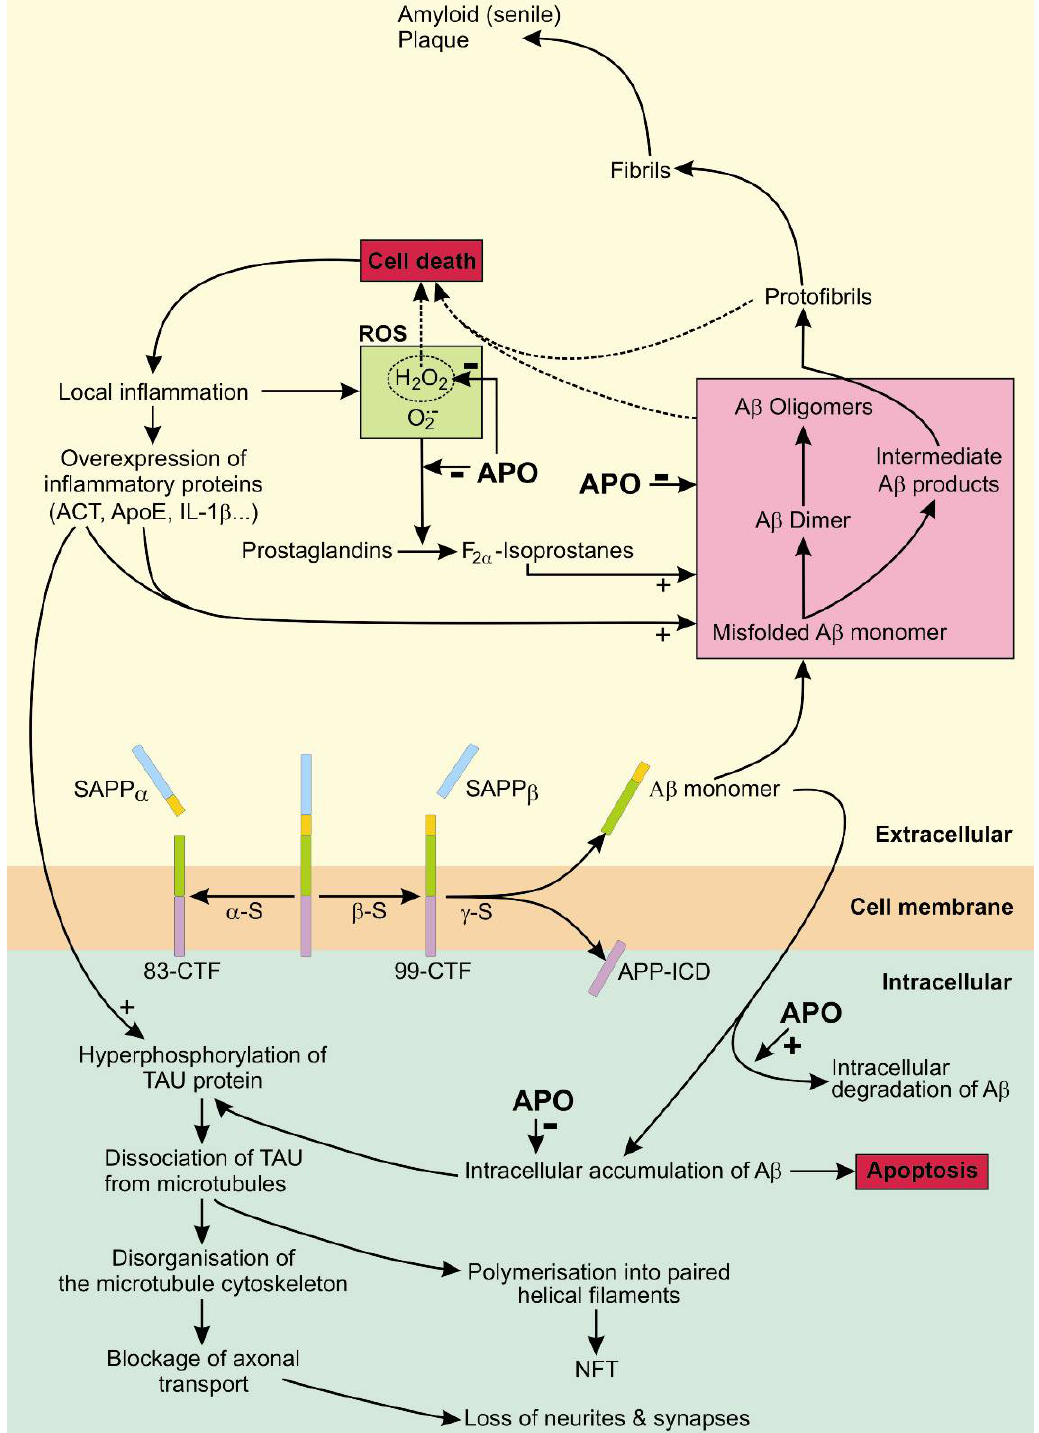
Figure 3. The non-amyloidogenic and amyloidogenic metabolic pathways of amyloid precursor protein (APP) [6,59,66,89–91,93,94,97–101]. APO (apomorphine); SAPP α (soluble peptide APP α ); SAPP (soluble peptide APP ); A β (A β 42 peptide); α -S β β ( α -secretase); β -S ( β -secretase); γ -S ( γ -secretase); CTF-83 and CTF-99 (83 and 99-amino acid membrane bound C-terminal fragment), NFT (neurofibrillary tangles); APP-ICD (APP intracellular domain); ROS (reactive oxygen species);  (accentuated activity); − (attenuated activity). The effect of APO is shown with bold ( + ) or ( − )